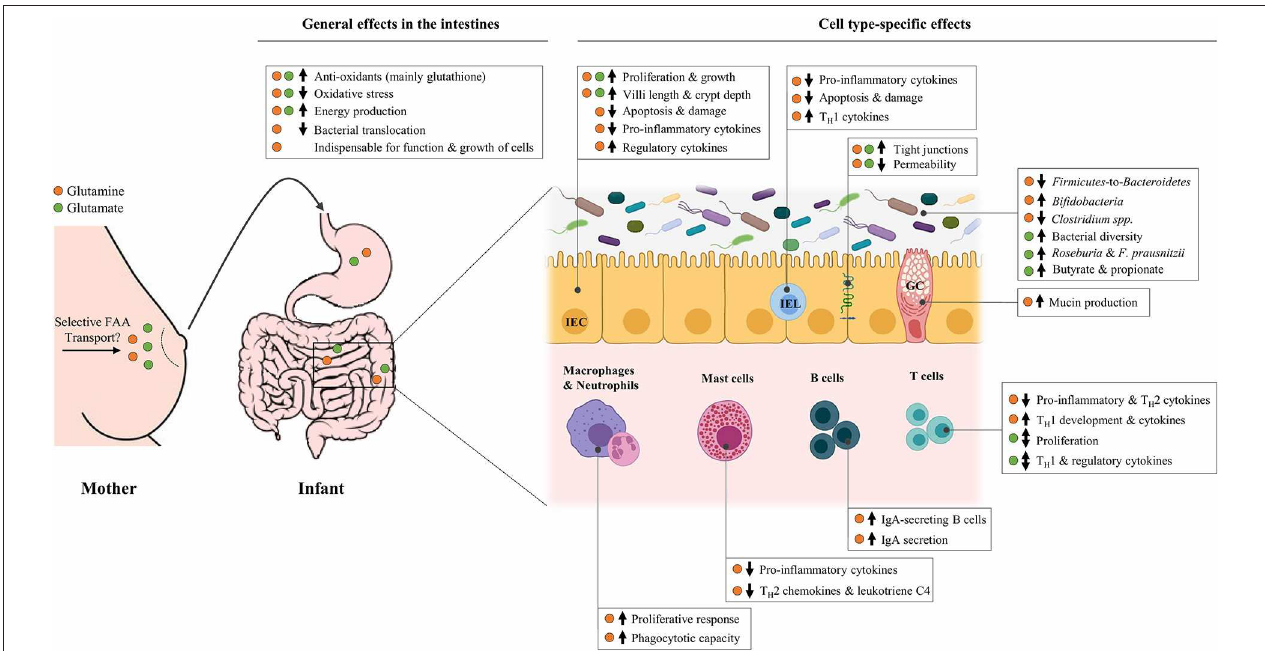
FIGURE 1 | Overview of the potential effects of free glutamine and glutamate, selectively secreted in human milk by mammary gland cells, in the developing infant gut. The ↑ and ↓ indicate an upregulation and downregulation, respectively, of the corresponding target following in vitro and/or in vivo supplementation with glutamine (•) or glutamate ( •). Effects are limited to those that are relevant in the context of allergic sensitization and infections. FAA, Free amino acid; IEC, Intestinal epithelial cell; IEL, Intraepithelial lymphocyte; GC, Goblet cell; T H 1, T-helper 1 cell; T H 2, T-helper 2 cell; IgA, Immunoglobulin A; F. prausnitzii , Faecalibacterium prausnitzii